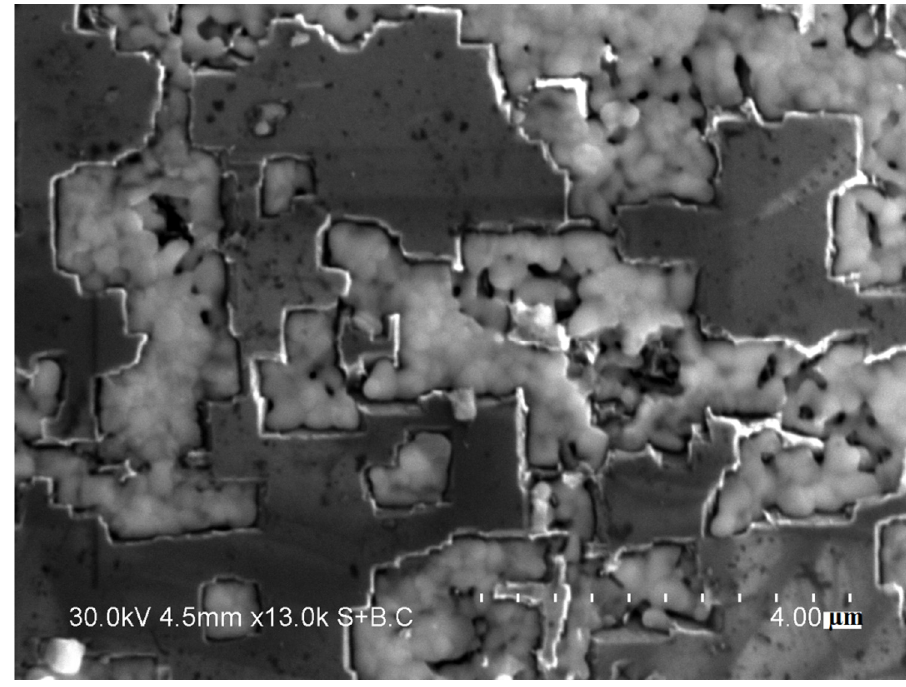
Figure 2. Morphology of the Mo-containing island structures on the {100} facets, 10-900-30-HP.